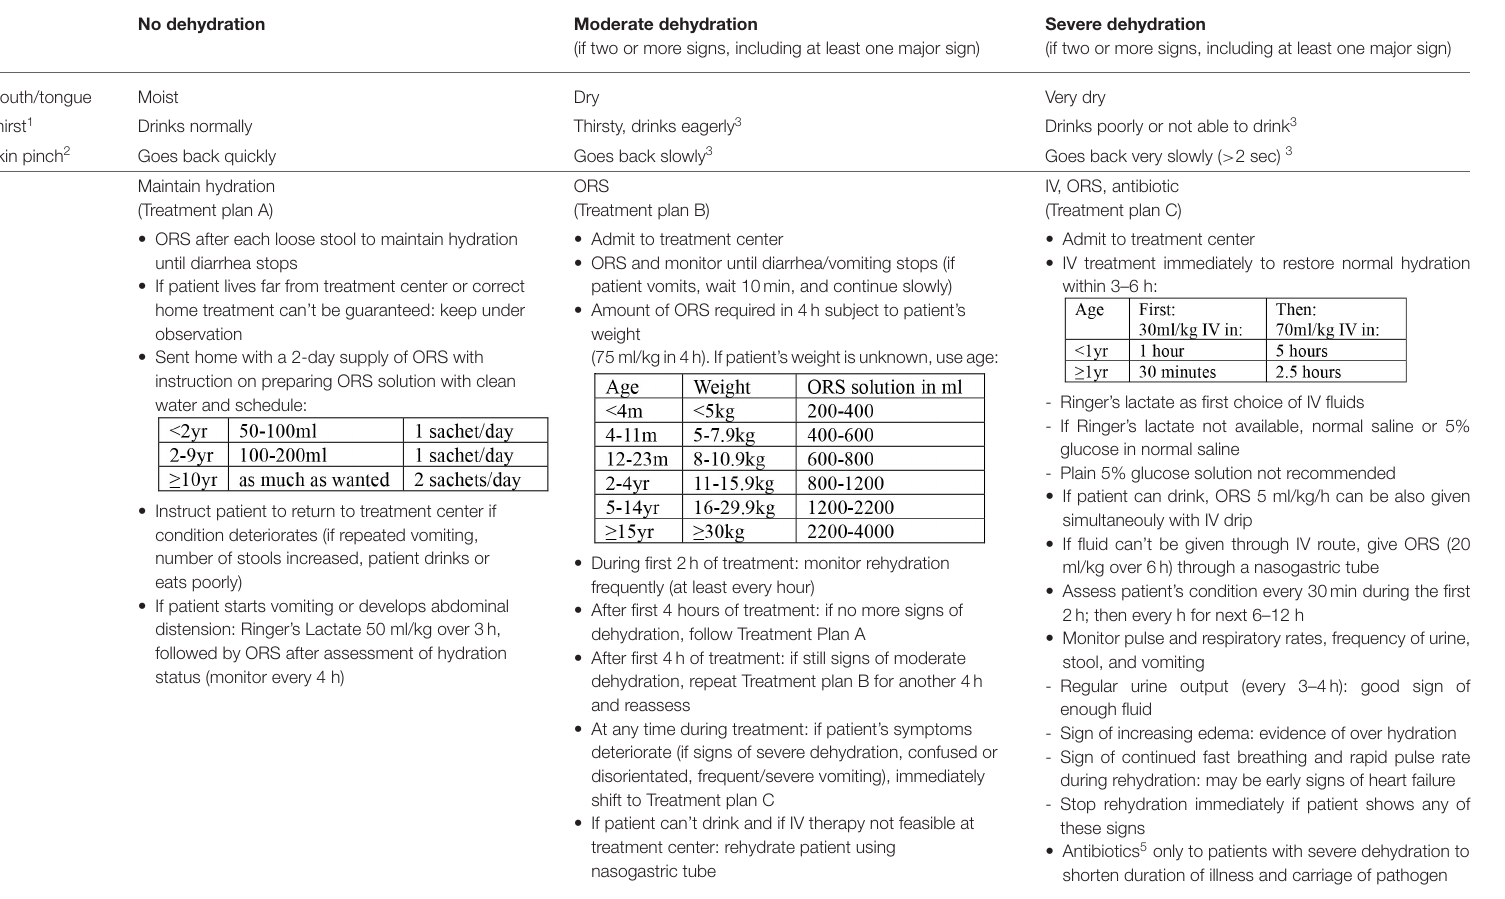
Acute Watery Diarrhea (AWD)